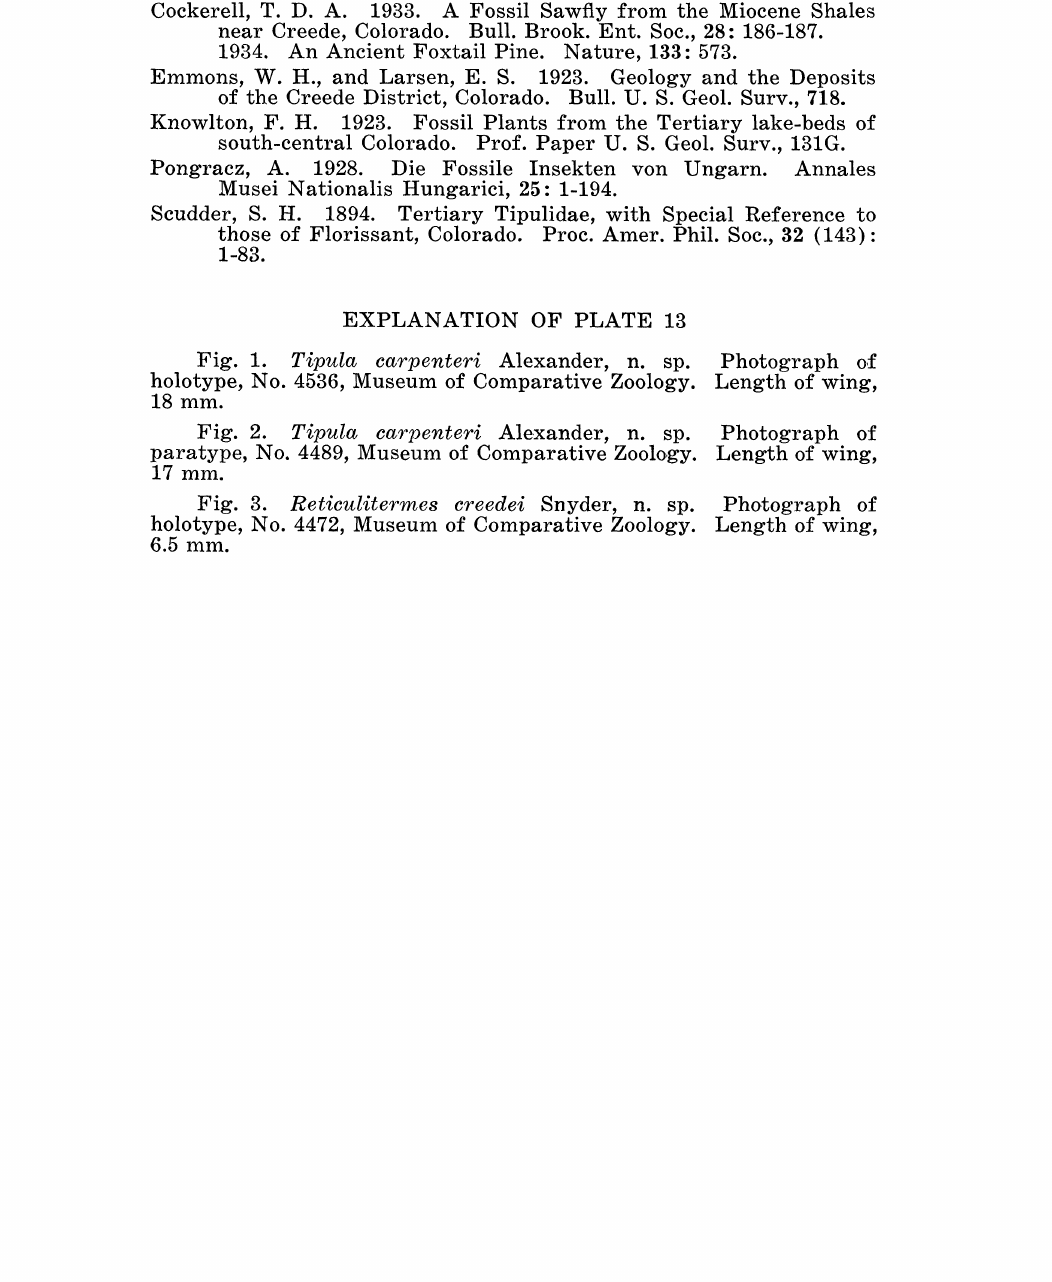
Fig. 1. Tipula carpenteri Alexander, n. sp. holotype, No. 4536, Museum of Comparative Zoology. 18 mm. Fig. 2. Tipula carpenteri Alexander, n. sp. Fig. 3. Reticulitermes creedei Snyder, n. sp. holotype, No. 4472, Museum of Comparative Zoology. 6.5